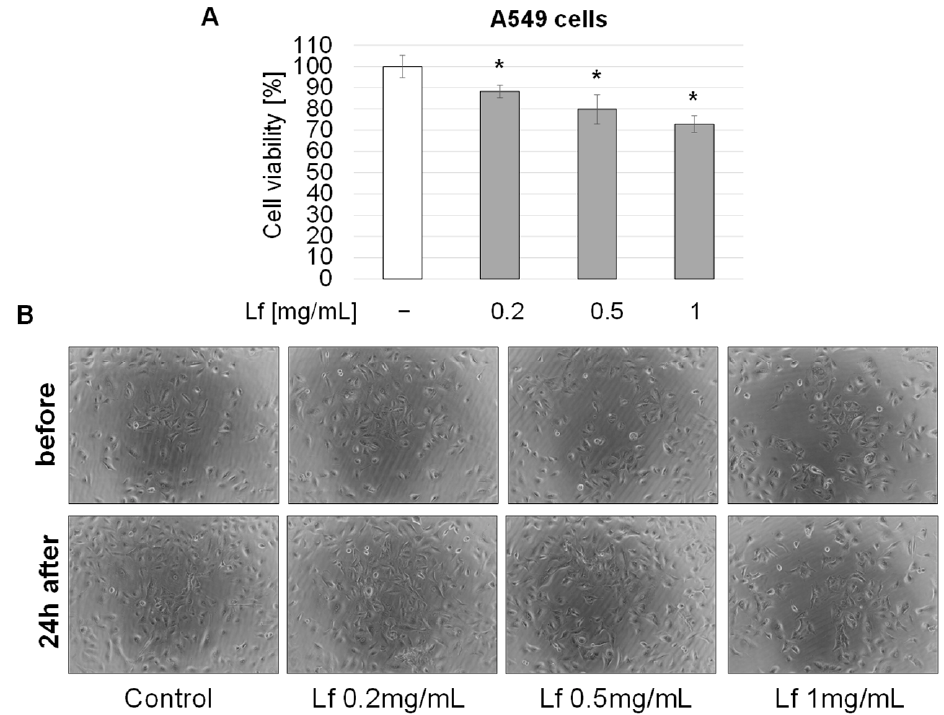
Figure 1. Effect of recombinant human lactoferrin (rhLf) on lung cancer cell growth. ( A ) A549 cells were cultured in the presence of rhLf (Lf) at indicated concentrations for 24 h. Viable cells were quantified by a WST assay. The results were expressed as a percentage of control cells and presented as the mean ± SD of three experiments performed in duplicate; ( B ) representative cell images before and 24 h after treatment visualized the effect of rhLf on cancer cell growth. (100 × magnification). * p < 0.05 compared to the control.